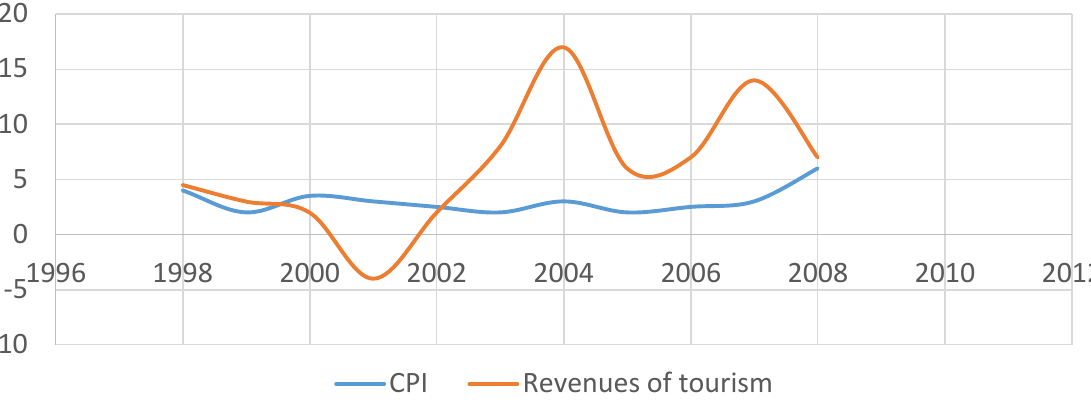
Figure 3. Development of revenues from tourism and Consumer Price Index for the period 1998– 2008 (values representing the average of percentual year-to-year differences of 23